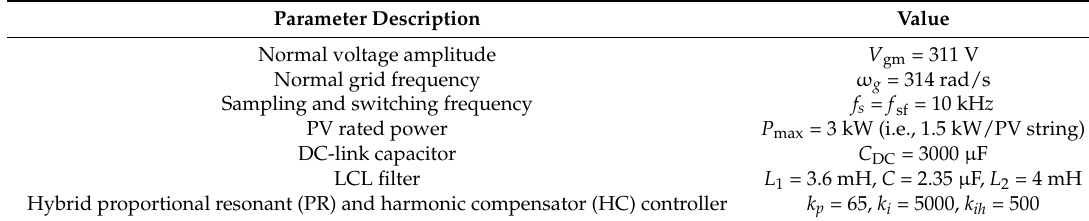
Table 2. Simulation parameters of the single-phase grid-connected PV system.